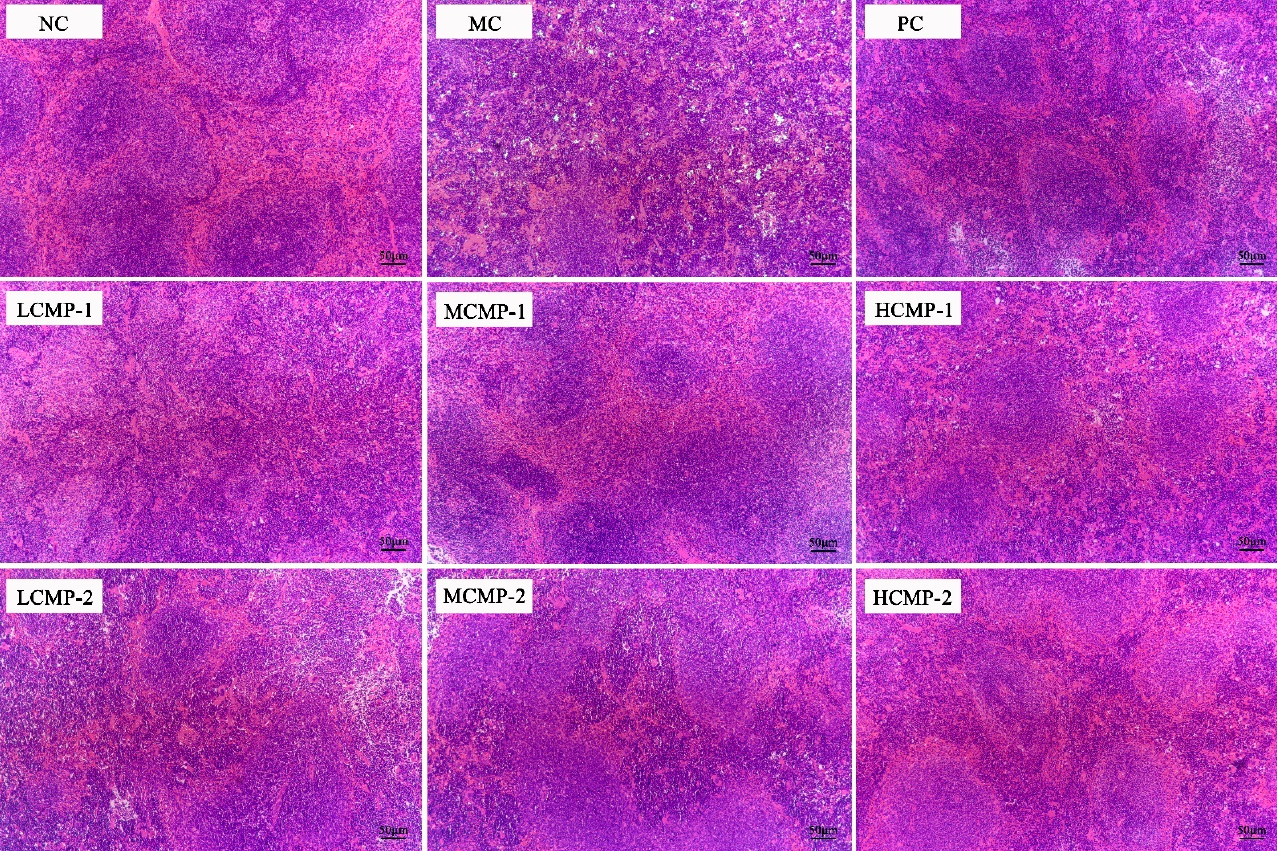
Figure 2. Effects of CMP-1 and CMP-2 on the morphology of the spleens of mice (HE, 200 ×).